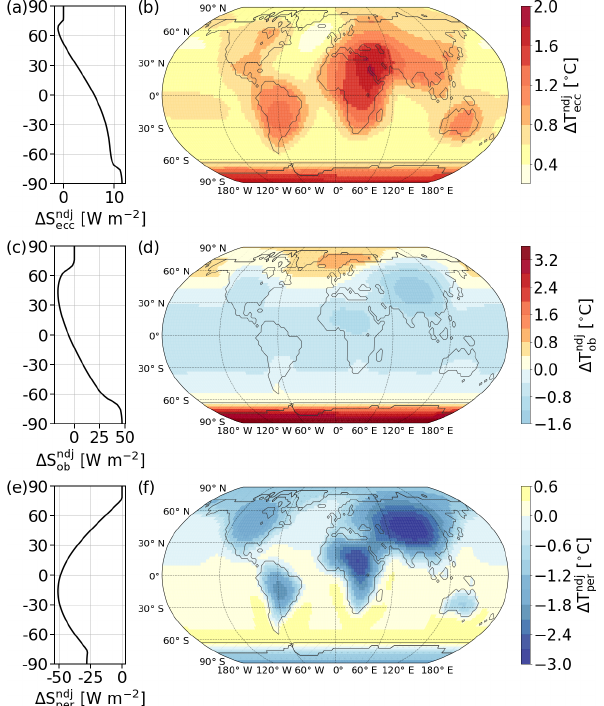
Figure B1. Difference in solar insolation (left) and temperature (right) caused by extremes in the orbital parameters as listed in Ta- ble 3 for eccentricity (a, b) , obliquity (c, d) , and precession of the perihelion (e, f) from November to January (NDJ). Model configu- ration as in Fig. 14. Obliquity has the largest impact on simulated temperatures, closely followed by precession. High eccentricity cor- responds to overall increased insolation and temperatures, with the largest increase in insolation towards the middle southern latitudes. Temperatures in the high eccentricity state change the most over Antarctica and continental areas near the Equator with respect to the low eccentricity simulation. A decrease in insolation in the Northern Hemisphere and increase in the Southern Hemisphere characterizes the high obliquity state when comparing it to the low obliquity one. Temperature increases are found in the polar regions, especially over Antarctica. Changes to precession have the strongest impact on low-latitude insolation and on temperatures in continental areas. NDJ insolation and temperatures are larger when perihelion occurs at the December solstice.